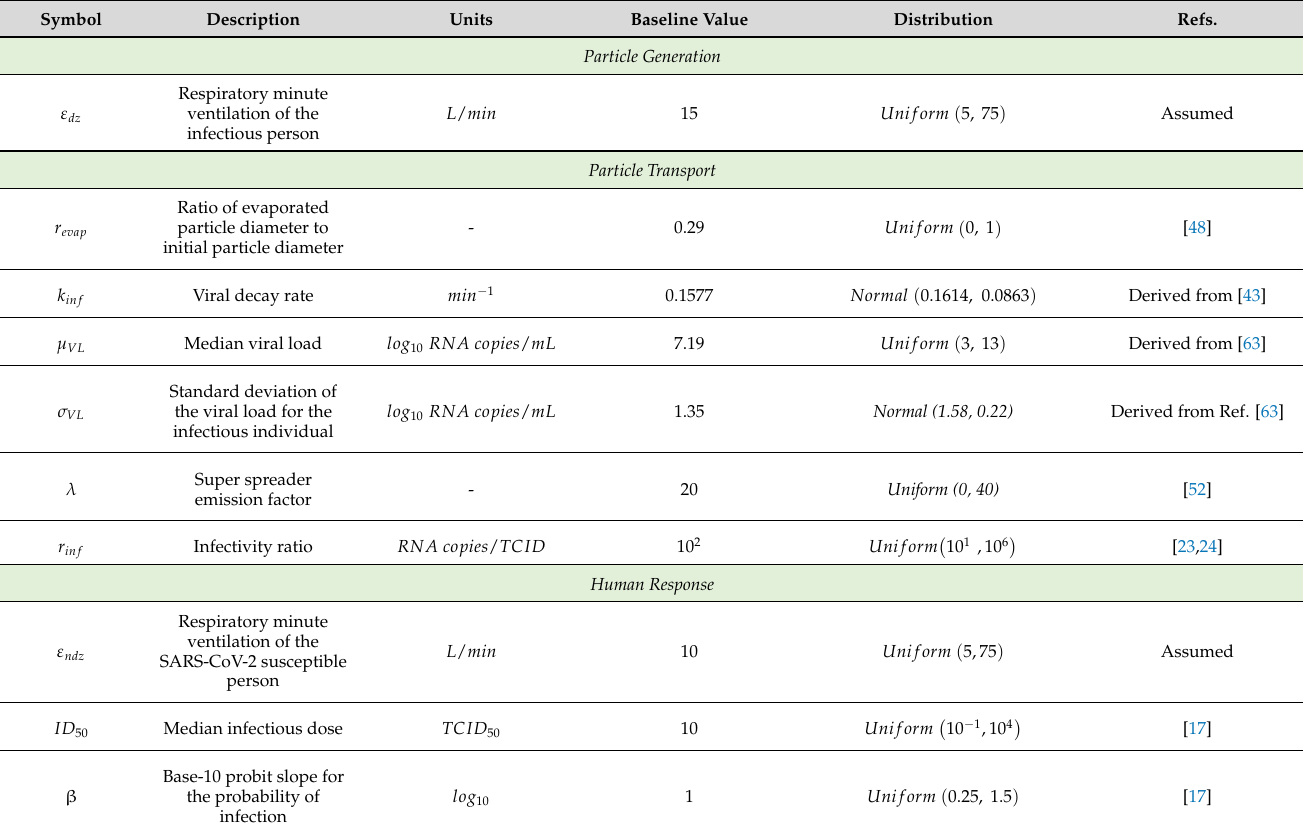
Table 2. Parameters with distributions for sensitivity